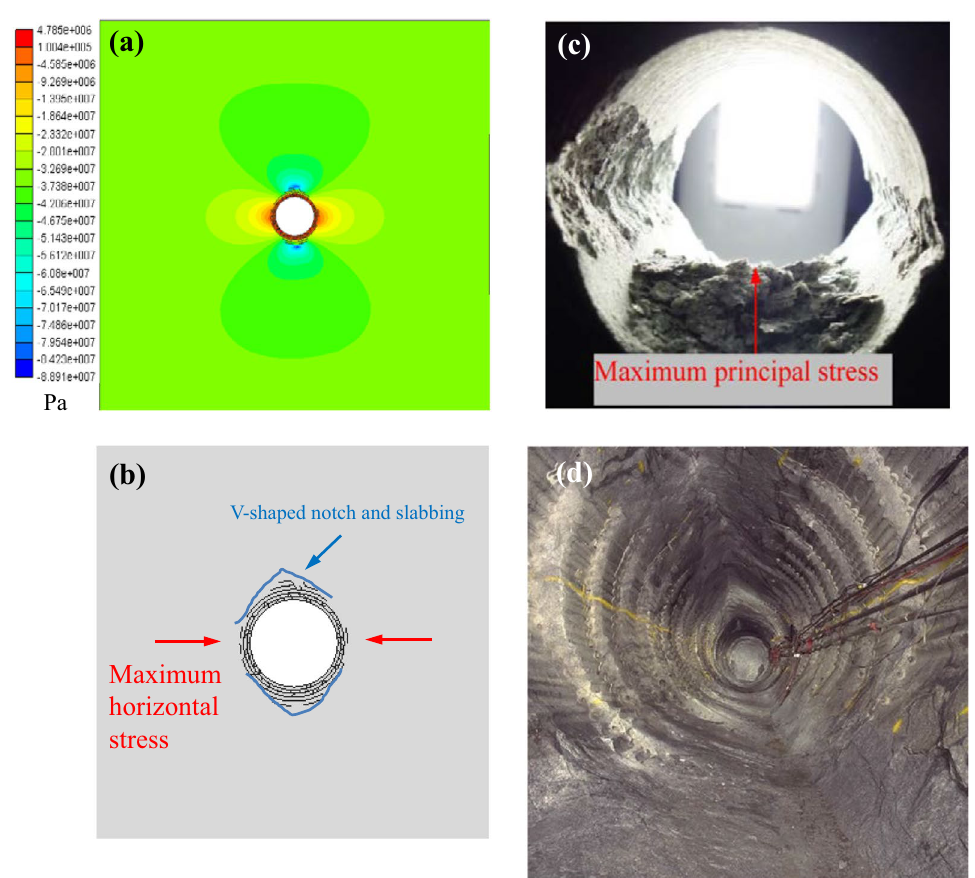
Fig. 5 Comparison of results of the circular cavern induced by exca- vation unloading effect. a Maximum principal stress contours derived from numerical simulation; b Crack distribution derived from numer-